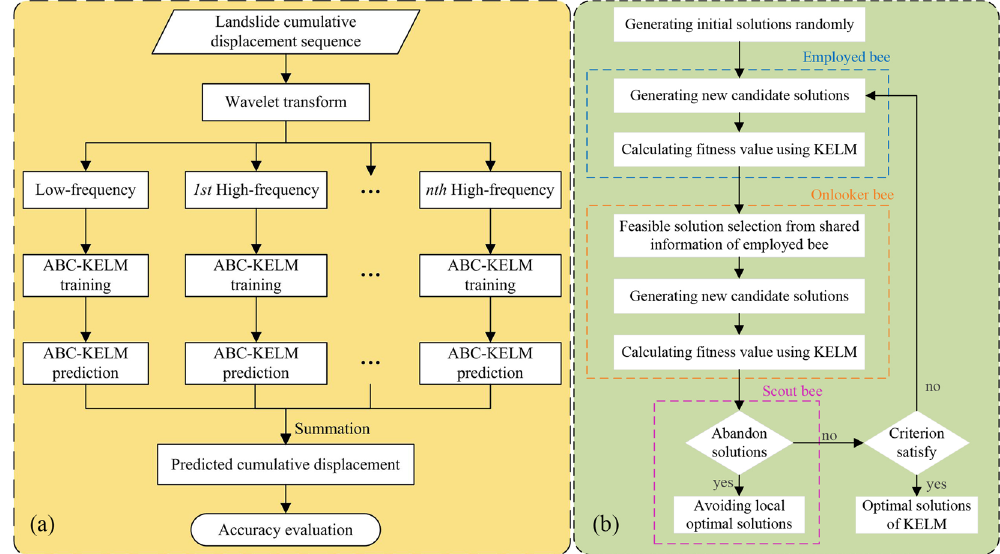
Figure 10. ( a ) The flowchart of the proposed forecast method; ( b ) the hybrid model of